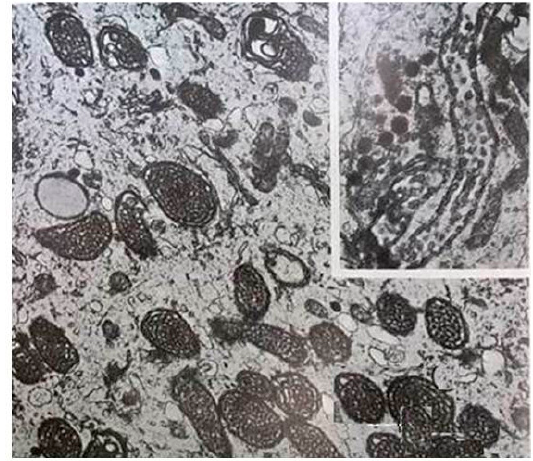
Figure 1. Large amounts of mitochondria are present in pinealocytes of the Syrian hamster (34,000×). Inset shows a longitudinal section of mitochondrion with cristae arranged like a string of beads (44,500×). Modified from Bucana et al. [89].